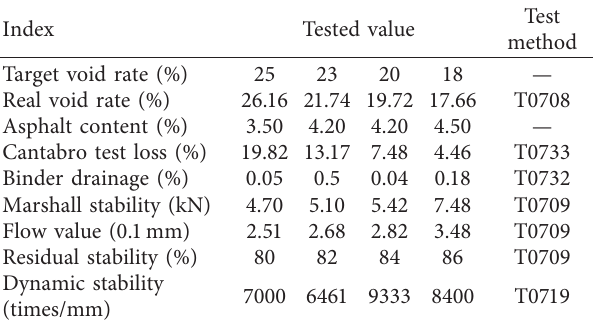
Figure 1: Gradation curves. Table 2: Road performance of porous asphalt mixture.